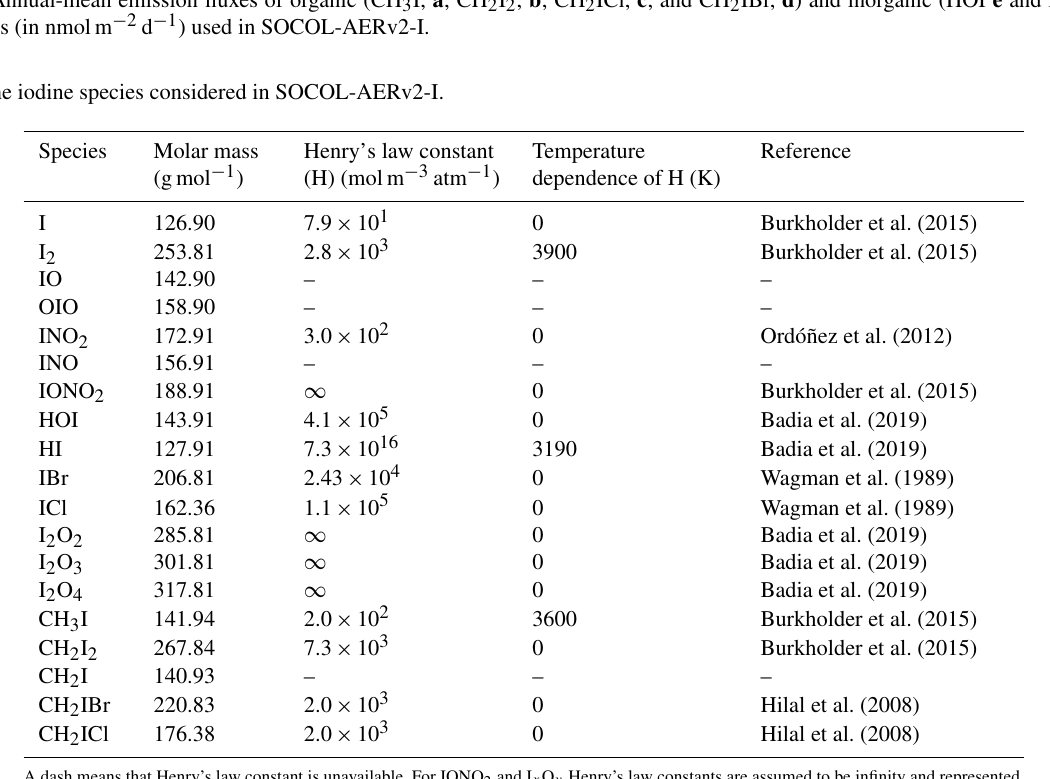
Figure 1. Annual-mean emission fluxes of organic (CH 3 I, a ; CH 2 I 2 , b ; CH 2 ICl, c ; and CH 2 IBr, d ) and inorganic (HOI e and I 2 f ) iodine